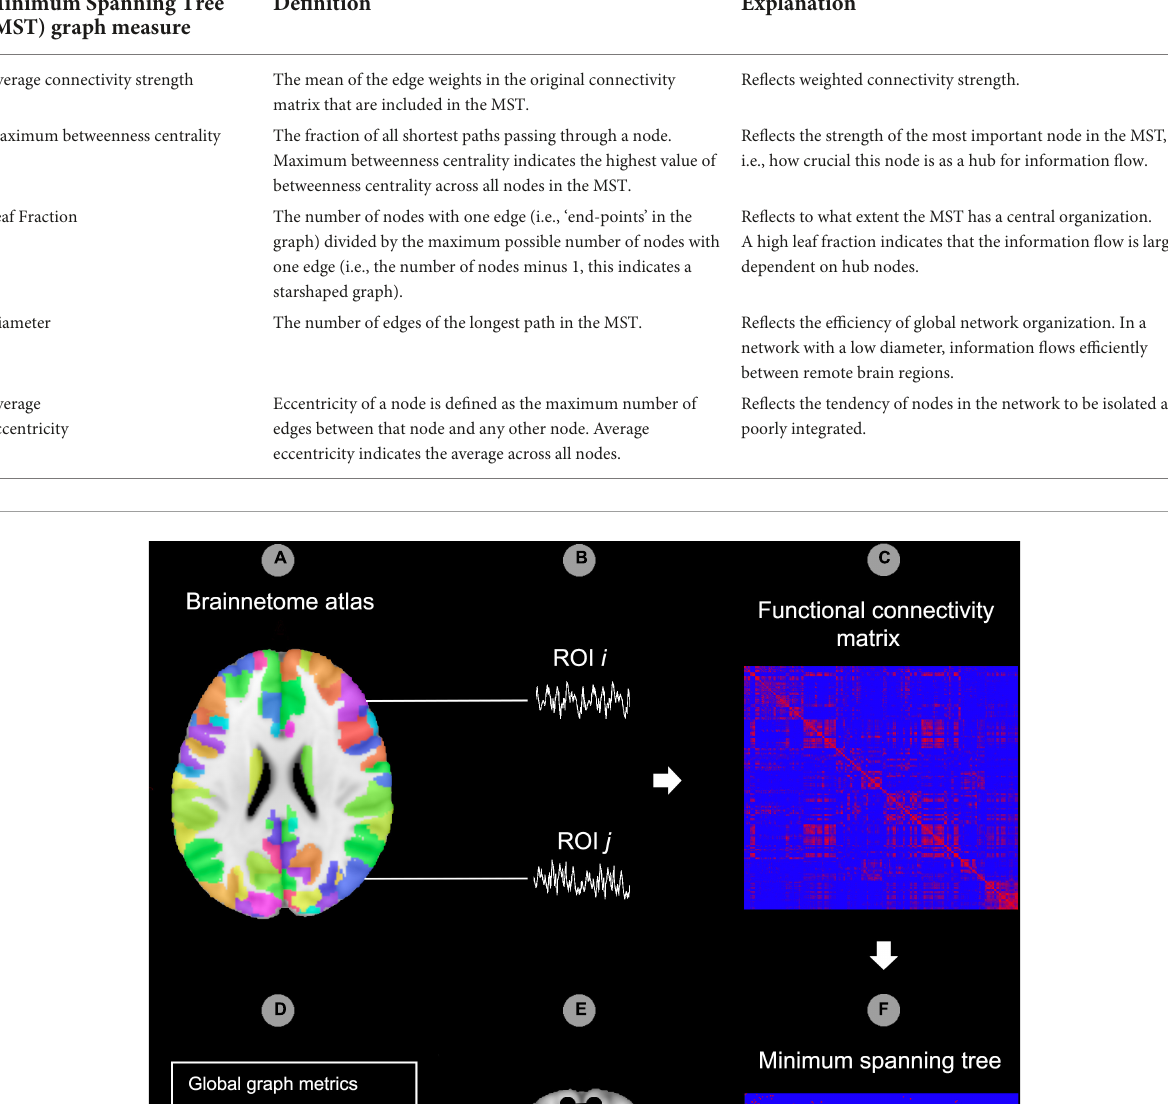
TABLE 2 Definitions and interpretations of Minimum Spanning Tree (MST) graph measures (Tewarie et al., 2015b).